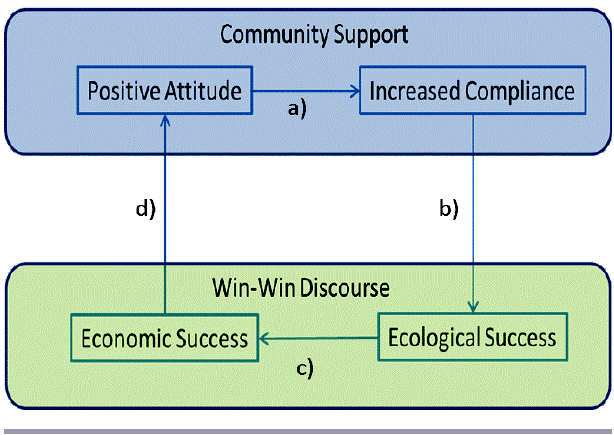
Fig. 1 . The community support and marine protected area success